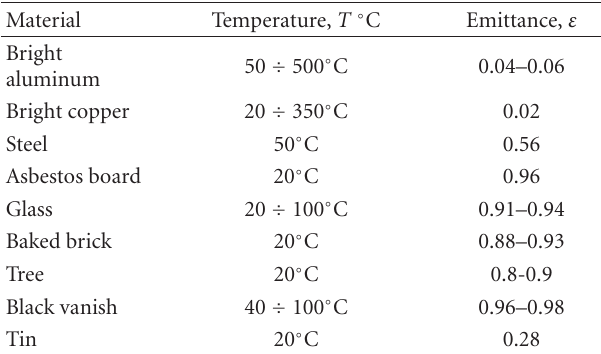
Table 2: Naschekin [17, page 331], Emittance, ε (Emissivity). Material